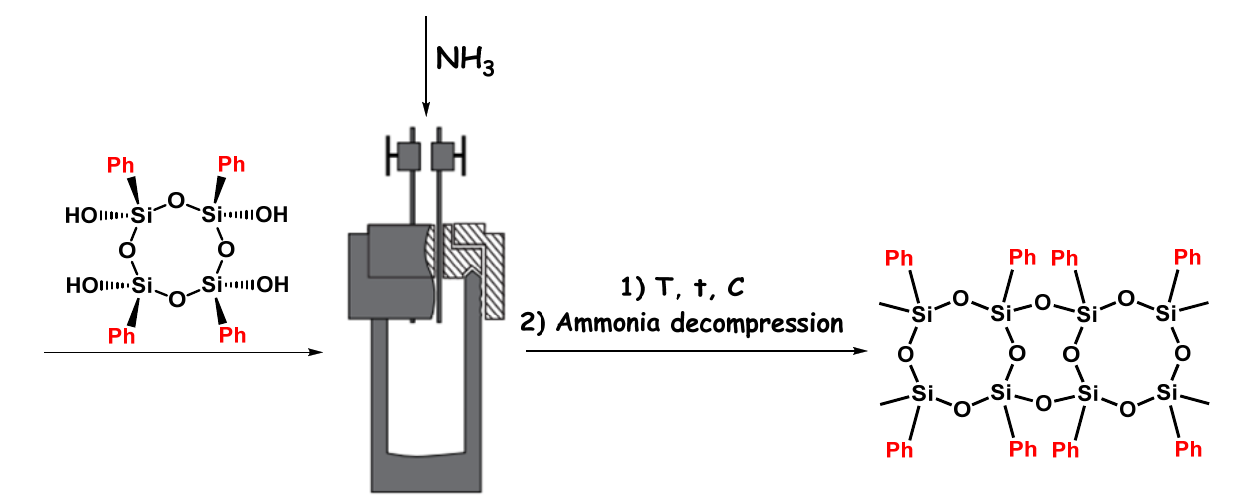
Figure 1. General scheme of L-PPSQ synthesis in ammonia medium.